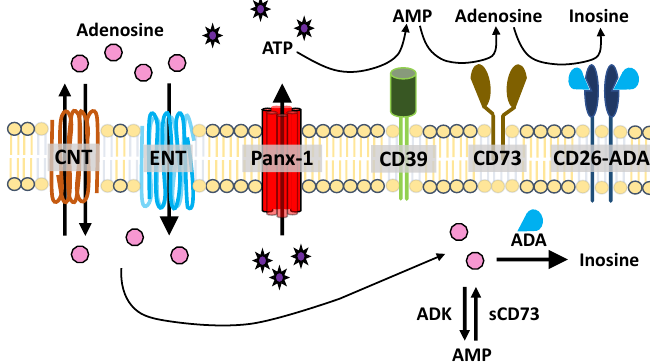
Figure 2. ATP release and metabolism. ATP is released through hemichannels, such as Panx- 1. ATP (and ADP) are degraded into AMP by CD39. AMP is catabolized into adenosine by CD73. Adenosine is deaminated into inosine by adenosine deaminase (ADA), which is associated with CD26. Concentrative and equilibrated nucleoside transporters (CNT, ENT) facilitate nucleoside uptake and transport. Intracellular adenosine can be deaminated by ADA or converted to AMP by soluble adenosine kinase (ADK). Intracellular AMP is converted to adenosine by soluble CD73